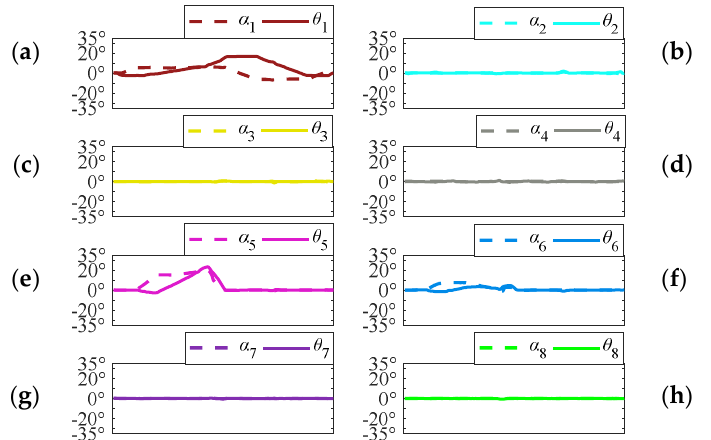
show the main range of the error change.